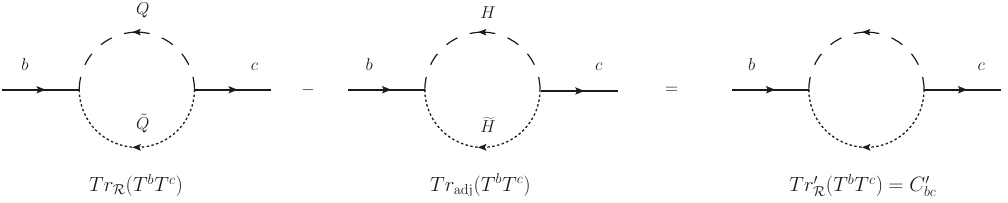
Figure 5 . One-loop correction to (cid:8) propagator in the di(cid:11)erence theory. The color factor is proportional to the (cid:12) 0 coe(cid:14)cient, so it vanishes for conformal